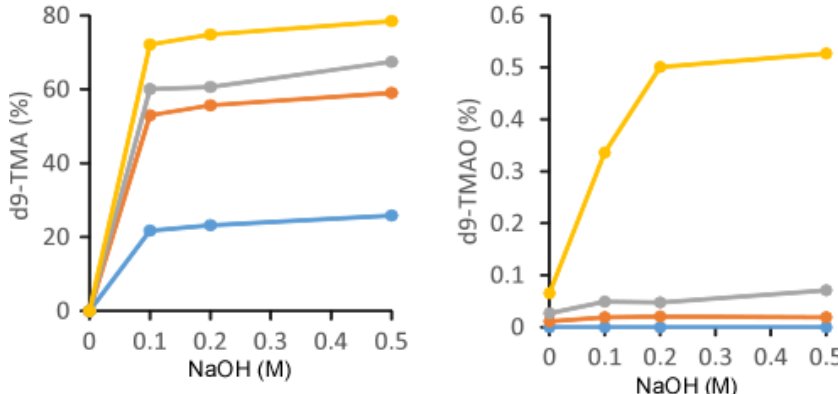
Figure 2. Recovery rates of TMA, TMAO, d9-TMA and d9-TMAO. Here, 500 μL of 40 μM (TMA + TMAO) was mixed with 20 μL of 1 mM (d9-TMA + d9-TMAO) and extracted with 2 mL hexane and